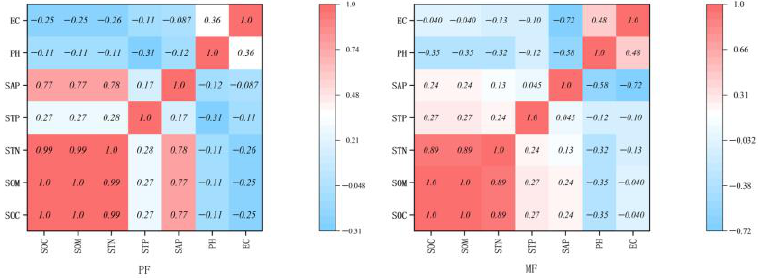
Figure 8. Relation between soil properties in preferential flow area and matrix flow area.